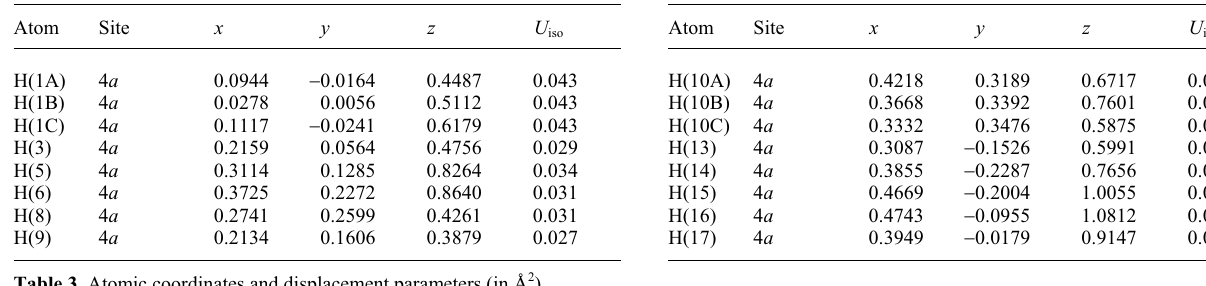
Table 2. Atomic coordinates and displacement parameters (in Å 2 ) .